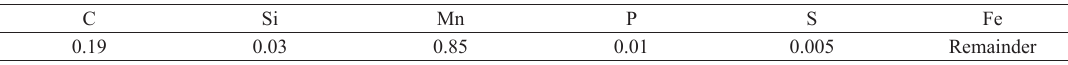
Table 1. Chemical composition of steel in mass